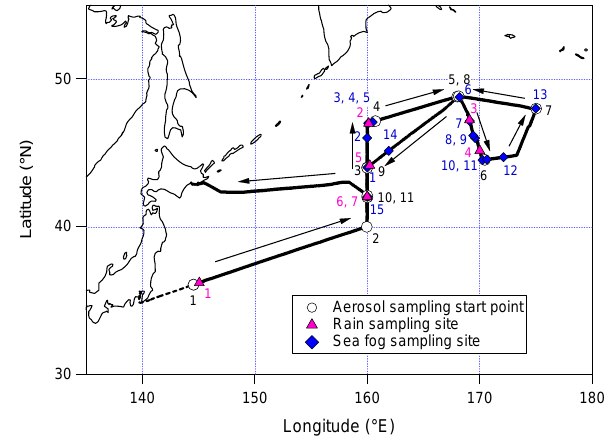
Figure 1. Cruise track of Leg 1 of the KH-08-2. White circles, pink triangles, and blue diamonds indicate aerosol, rain, and sea fog sampling locations during the cruise, respectively. Each aerosol sampling start point represents the end of the previous sampling period. Dotted line indicates that no aerosol sampling was conducted. Black, pink, and blue numbers represent the sample numbers of aerosol, rain, and sea fog, respectively.